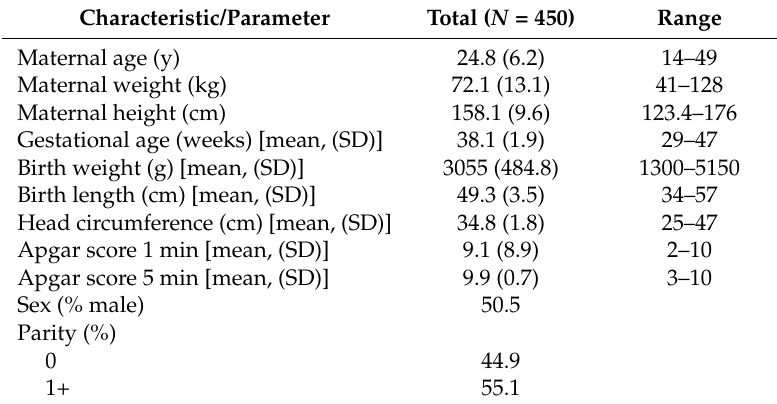
Table 2. Obstetric and birth outcomes.